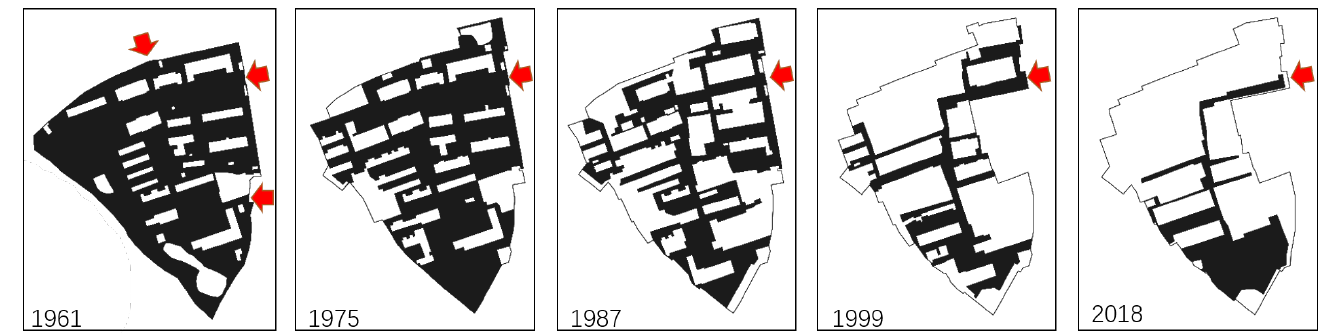
Figure 7. Public space map of the AMS compound (1961–2018).